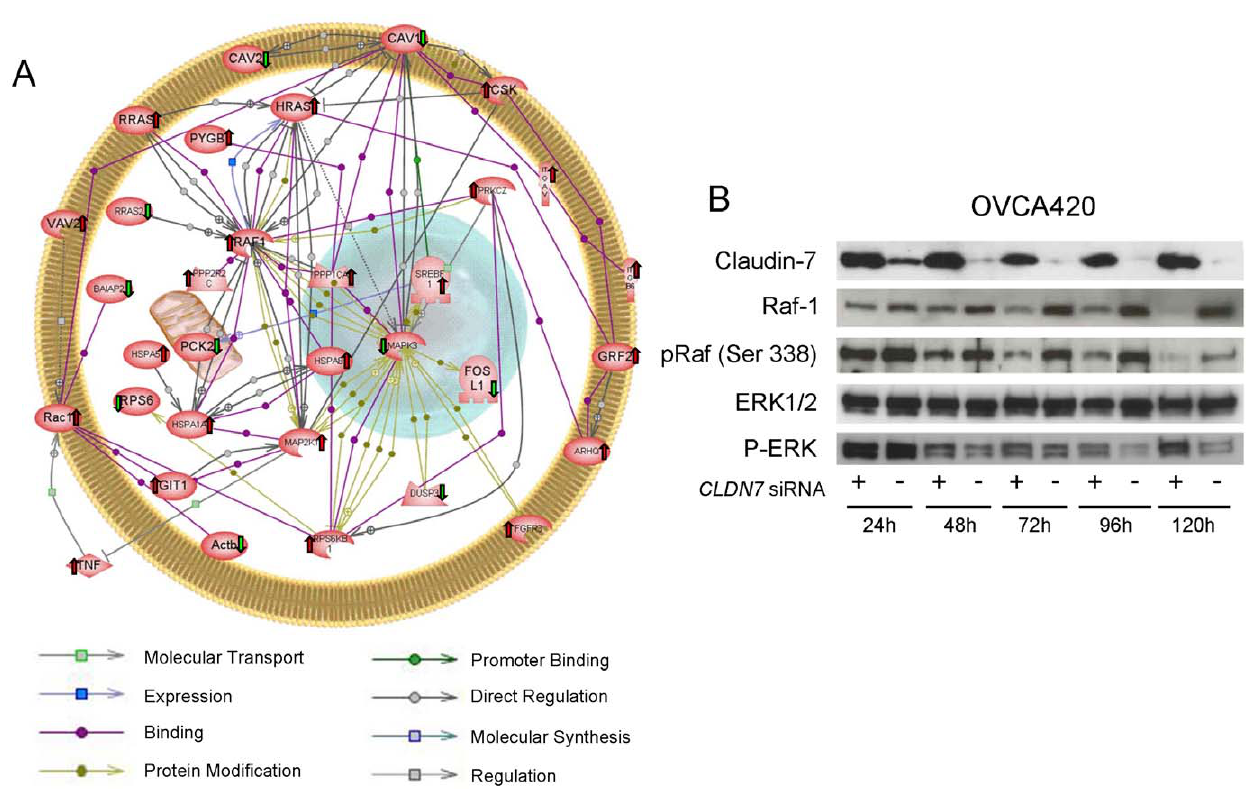
Figure 6. Pathways affected by CLDN7 knockdown. A. Pathway Studio analysis. Direct interactions of 33 significantly upregulated (red upward arrow) or downregulated (green downward arrows) genes are shown. The legend for the different types of interactions is shown below the map. B. Immunoblot analysis of Erk1/2, phospho-Erk1/2 (p-Erk) and Raf-1 and phospho-Raf (Ser-338) in OVCA420 at the indicated time points following CLDN7 knockdown.